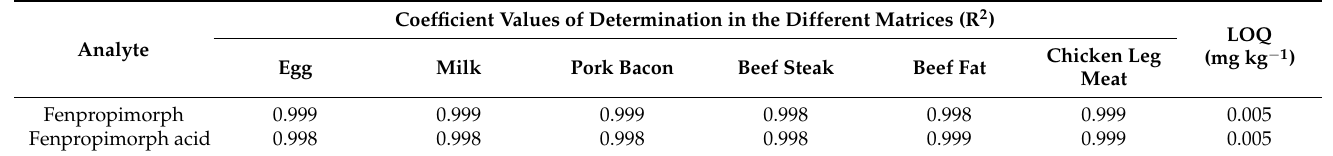
Table 2. Linearity of matrix-matched standard calibration and limits of quantitation (LOQs) of the target analytes. Coefficient Values of Determination in the Different Matrices (R 2 ) Analyte